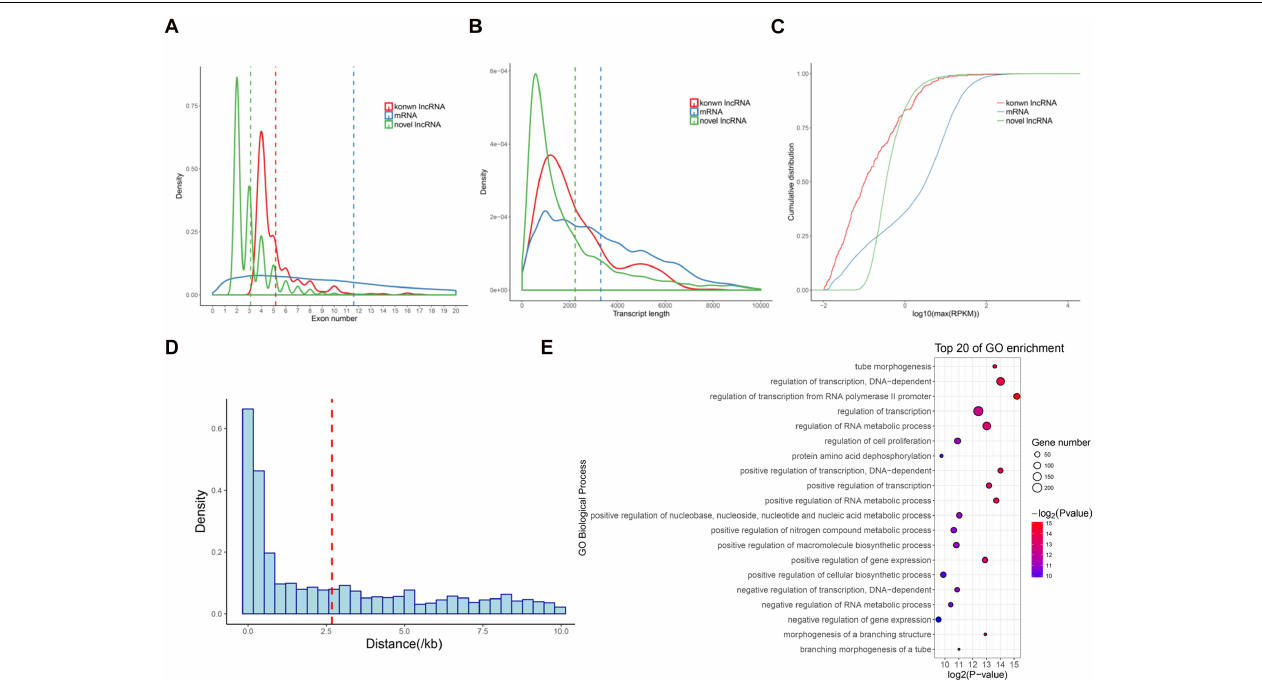
FIGURE 2 | Characterization of lncRNAs in pig pineal glands. (A) Comparison of exon number between lncRNAs and mRNAs. (B) Comparison of transcript length between lncRNAs and mRNAs. (C) Comparison of expression level between lncRNAs and mRNAs. (D) The distribution of the distance from lincRNAs to their nearest neighboring protein-coding genes. The average (red dashed line) distance is indicated. (E) GO biological processes analysis of the neighboring protein-coding genes of the